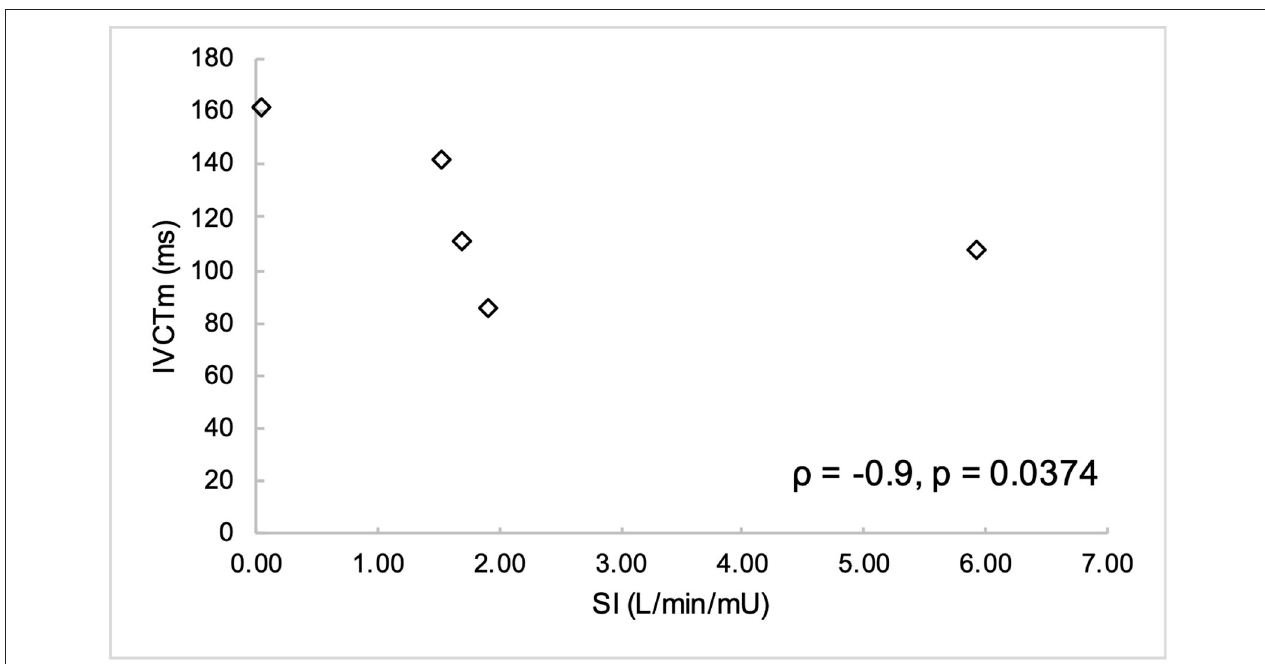
FIGURE 5 | Isovolumetric contraction time (IVCT m ) was negatively correlated with insulin sensitivity (S I